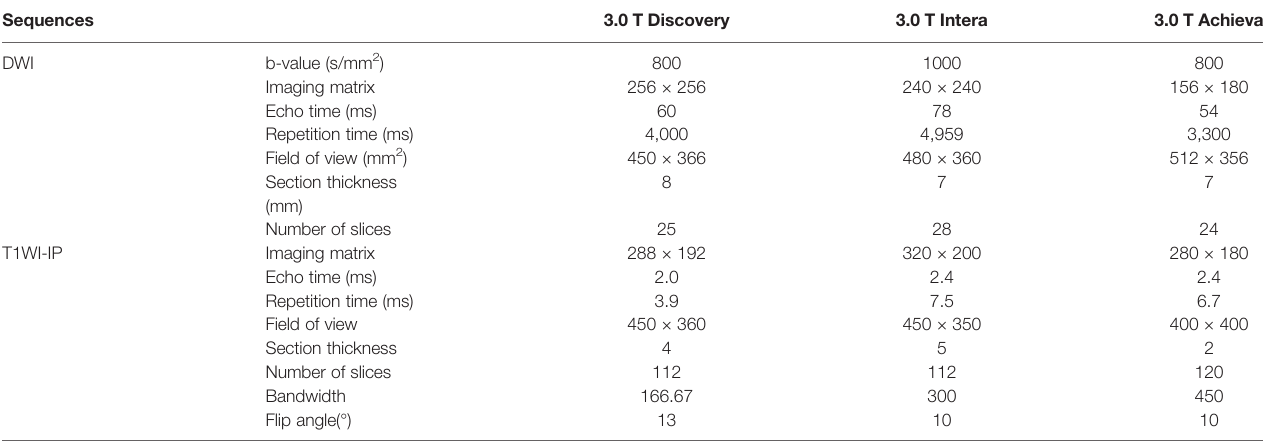
TABLE 1 | MR imaging parameters of DWI and T1WI-IP sequence.